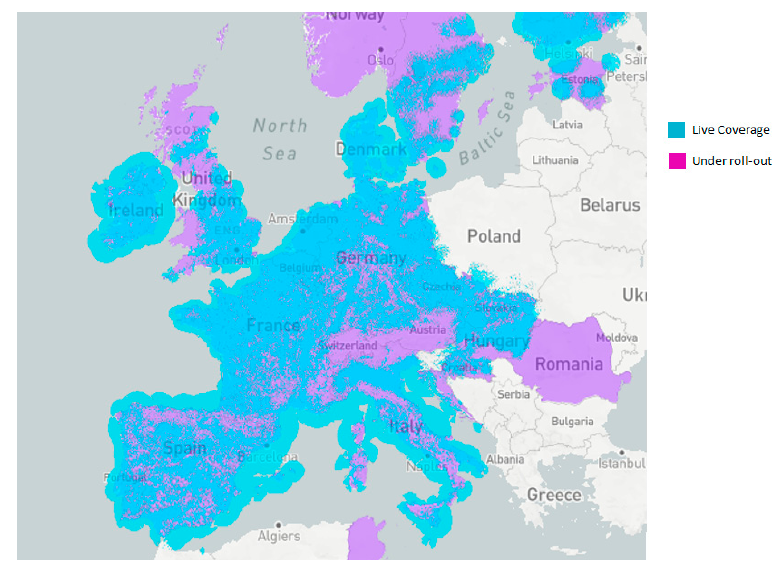
Figure 2. SIGFOX coverage. Reference: [29].